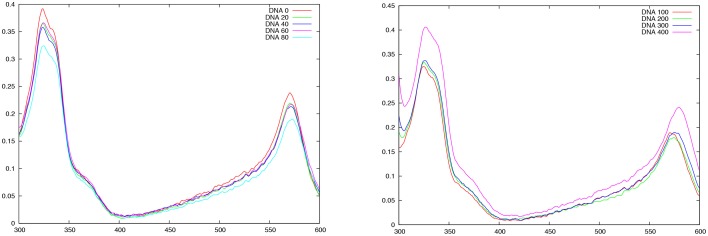
Absorption spectrum of FeC-3 (100 μM) in presence of increasing DNA concentration. Left panel from 0 to 80 μM B-DNA, Right panel from 100 to 400 μM B-DNA